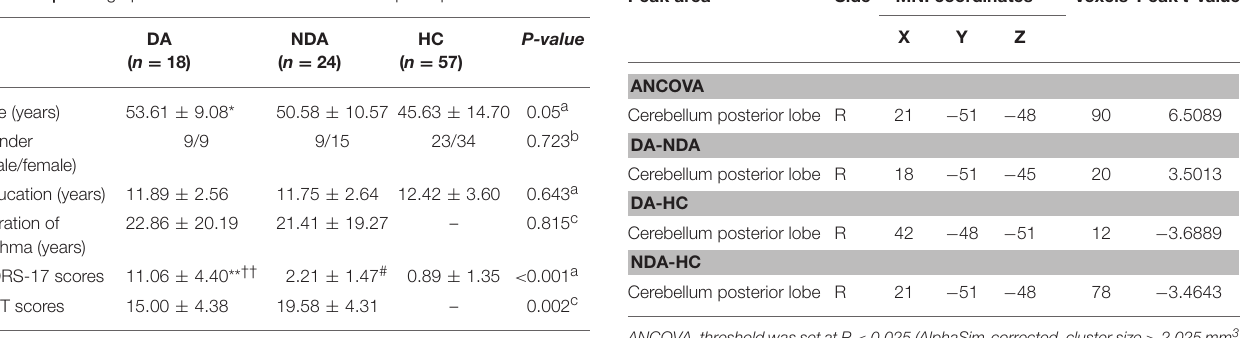
TABLE 1 | Demographics and clinical characteristics of